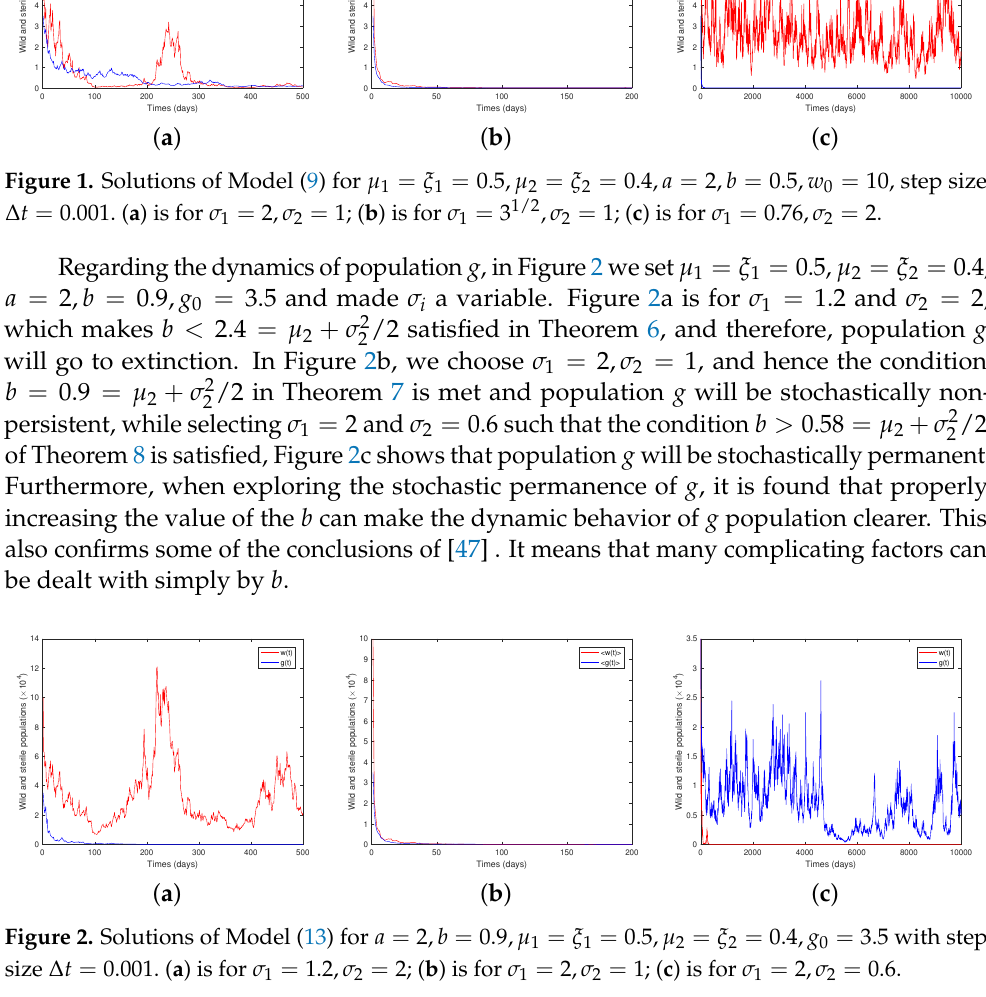
= 3 1/2 , σ = 1; ( c ) is for σ 2 1